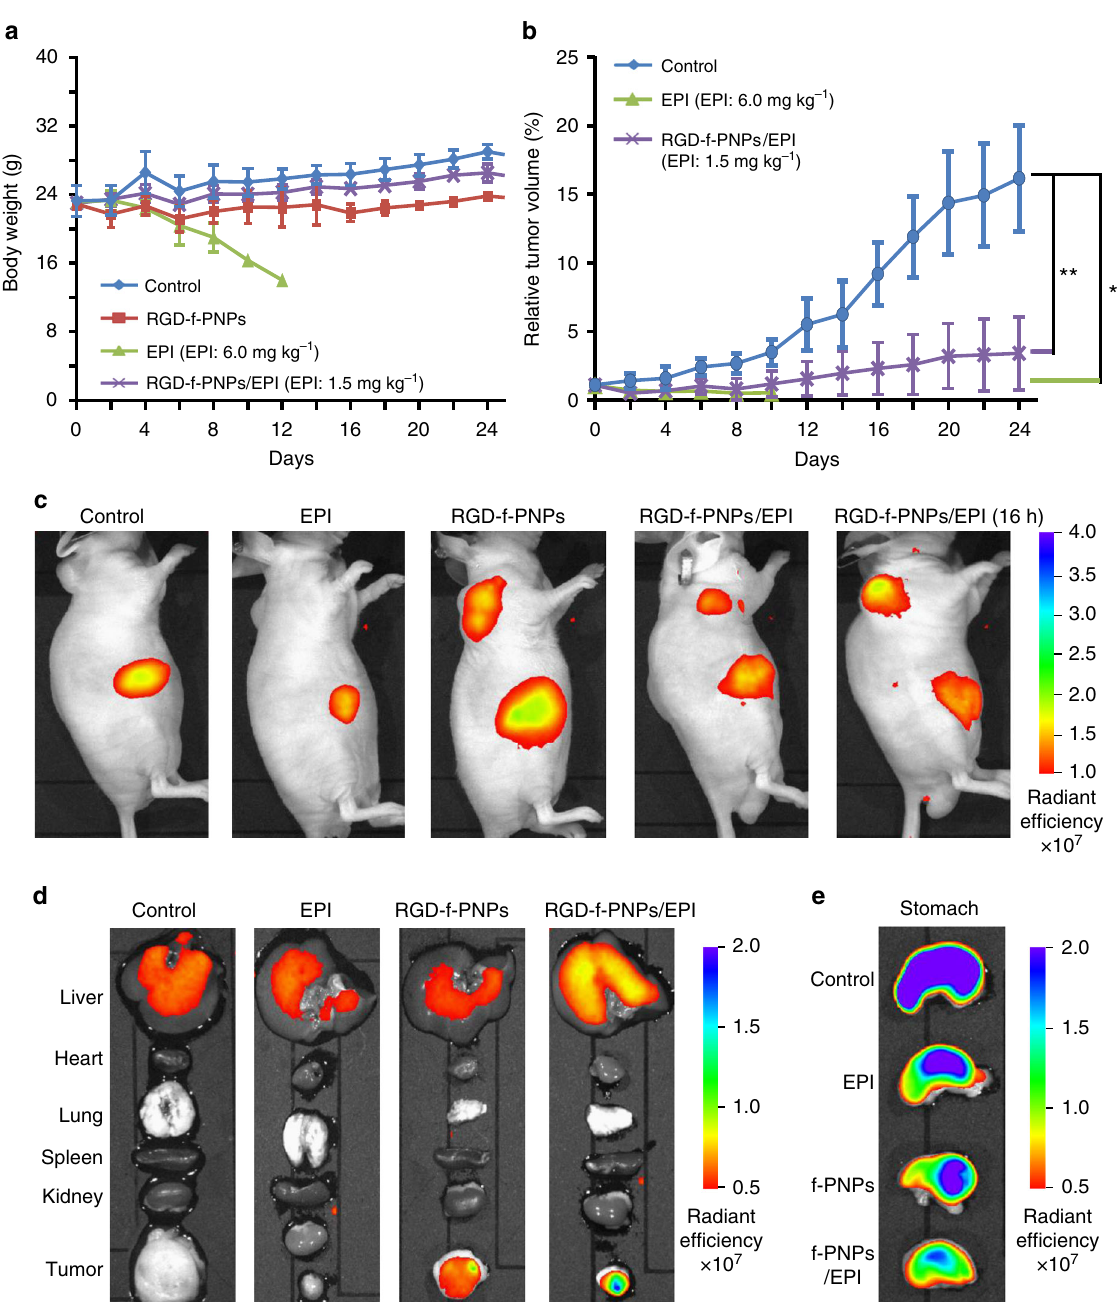
Fig. 5 In vivo targeted tumor imaging and enhanced anti-tumor ef fi cacy of RGD-f-PNPs/EPI. Tumor-bearing nude mice were treated with various drug formations at the dose of 1.5 mg kg − 1 (RGD-f-PNPs/EPI) and 6 mg kg − 1 (EPI) for 3 weeks. a Body weight of mice with the various treatments. No obvious side effects for the RGD-f-PNPs were observed in terms of signs of distress, lethality, or drop of body weights, while treatment of EPI resulted in signi fi cant lost in body weight and three out of fi ve animals died after 1 week of treatment. Error bars represent s.d. ( n = 5). b Growth curves of tumors in the mice after the various treatments. Tumor growth in mice treated with RGD-f-PNPs appeared to be similar to that of control group and both EPI and RGD-f-PNPs/ EPI groups signi fi cantly reduced tumor growth than control group ( p < 0.05). The data indicate the enhanced anti-tumor ef fi cacy of RGD-f-PNPs/EPI in vivo, as a result of its speci fi c tumor targeting and ef fi cient delivery and release process using RGD-f-PNPs. Error bars represent s.d. ( n = 5). Statistical signi fi cance was determined using an unpaired t test in tumor growth curve analysis, with * p < 0.05, ** p < 0.001. c In vivo whole animal imaging of NIR fl uorescence after intravenous injection via the tail vein in the form of saline, EPI alone, RGD-f-PNPs alone, and RGD-f-PNPs/EPI. After 30 min of RGD-f-PNPs and RGD-f-PNPs/EPI injection, the xenograft tumors were clearly visualized with NIR imaging at relatively low background. Another signi fi cant signal was detected from the abdominal region adjacent to the tumor injection site due to dietary components in the stomach ( e ). After 16 h of the RGD-f- PNPs/EPI injection, the fl uorescence at the tumor site increased likely due to the release of EPI while the abdominal signal remained unchanged. d Ex vivo NIR fl uorescence imaging in tumor and fi ve different organs collected after sacri fi cing the mice. Clear fl uorescence signal was observed from tumor of mice with injection of RGD-f-PNPs and RGD-f-PNPs/EPI, but not in the control or EPI-treated groups. e Ex vivo NIR fl uorescence imaging of stomach collected after sacri fi cing the mice. The fl uorescence from the stomach was due to the mice